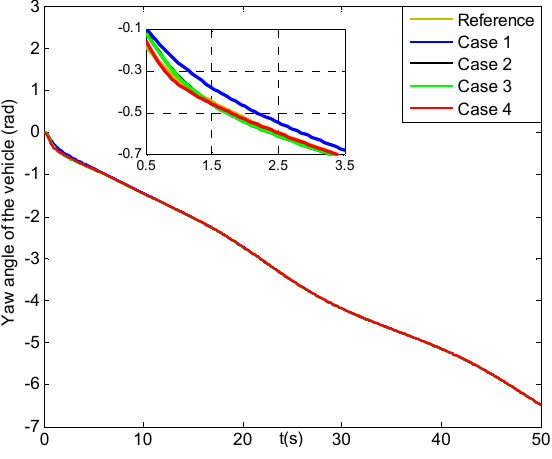
Figure 21. Yaw angles of the vehicle (four cases).